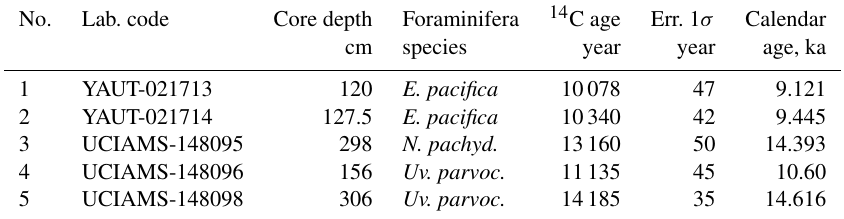
Table 1. AMS 14 C data in monospecies planktic foraminifera N. pachyderma sin. and benthic foraminifera Epistominella pacifica and Uvigerina parvocostata of core 41-2. All measured AMS 14 C data were calibrated by Calib 6.0 (Stuiver and Reimer, 1993) with Marine13 calibration curve (Reimer et al., 2013) with a surface water reservoir ages of 900 years (Max et al., 2014). In the case of using benthic foraminifera for dating, we accept that the difference in paired benthic–planktic foraminifera ages equals 1400 years, based on unpublished data and total regional results of Max et al. (2014). All radiocarbon ages were converted into calibrated 1 σ calendar age. No. Lab. code Core depth Foraminifera 14 C age Err. 1